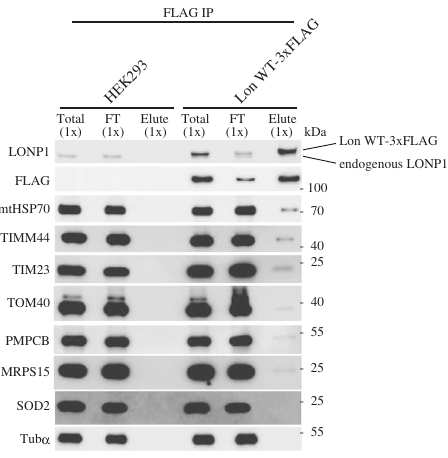
Fig. 6 LONP1 forms a complex with the mitochondrial protein import machinery. HEK293 cells carrying inducible plasmids expressing 3× FLAG- tagged wild - type LONP1 were cultured for 3 d in the presence of 1 ng/mL doxycycline. The cells were extracted with RIPA buffer after treatment with the reversible crosslinker (DSP). The supernatant was recovered as the total protein (Total) following sonication and centrifugation. The FLAG- tagged LONP1 protein was immunoprecipitated using anti-FLAG-tag mAb- magnetic beads. After magnetic separation, unbound proteins were recovered as the fl ow-through (FT). The magnetic beads were incubated twice with RIPA buffer containing FLAG peptides and recovered as eluate (Elute). After cleavage of a disul fi de bond in DSP, all samples were analyzed by immunoblotting. The experiments were repeated three times and representative data are